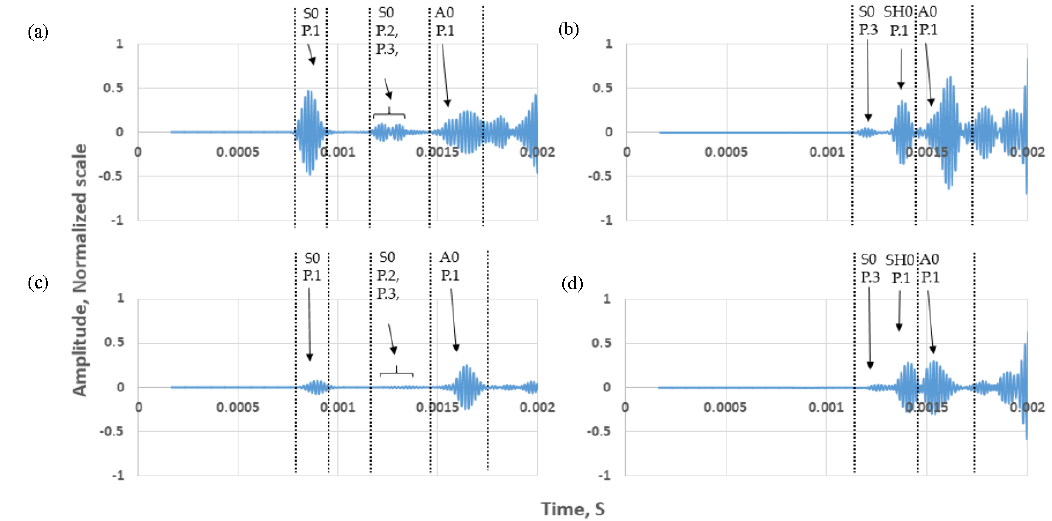
Figure 7. Normalized time-domain results for both excitation on the tank annular chime and wall; monitored waveforms are labelled according to the Path ID in Table 1. Case 1: ( a ) normal mode, ( b ) shear mode; and Case 2: ( c ) normal mode, ( d ) shear mode. Results are normalized to the maximum of all 4 signals.